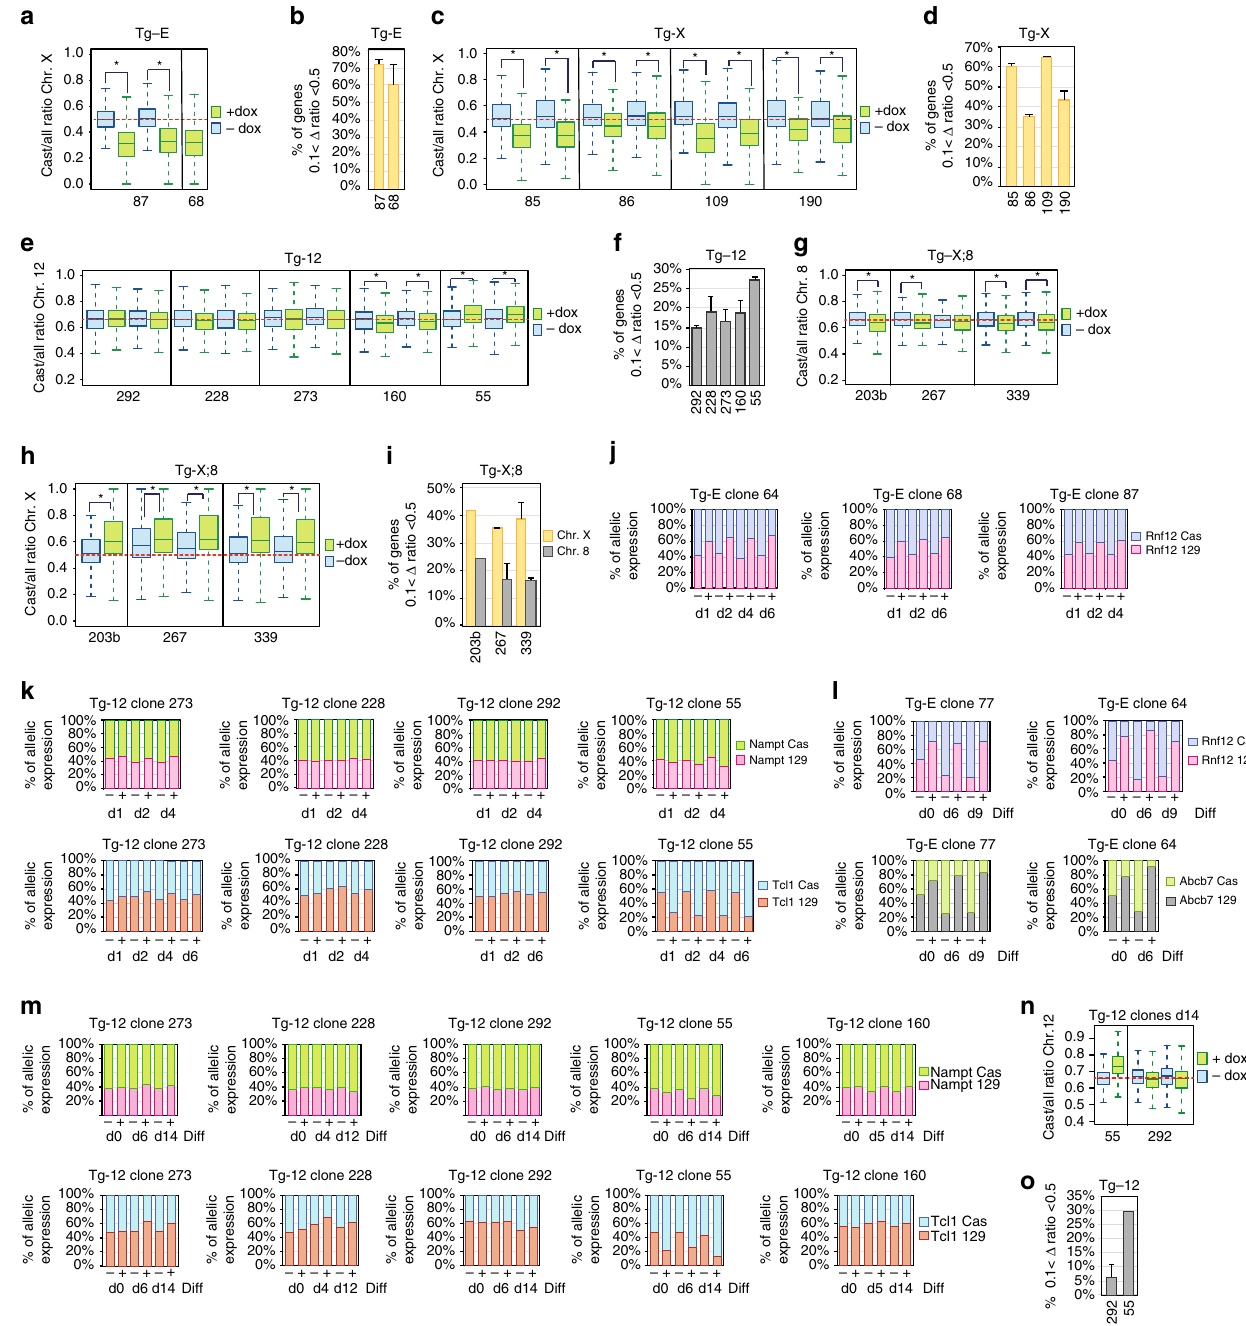
Fig. 3 Xist-mediated silencing at different genomic loci. a , c , h Box plot showing the Cast/all ratio of X-linked genes for Tg-E a , Tg-X c , and Tg-X;8 h clones after 5 days of doxycycline treatment in undifferentiated ESCs. e , g Box plot showing the Cast/all ratio of chromosome 12 and 8 genes in Tg-12 and Tg-X;8 clones after 5 days of doxycycline treatment in undifferentiated ESCs. * p < 0.05 Mann – Whitney U -test. b , d , f , i Bar graphs showing the percentage of genes with a Δ ratio between 0.1 and 0.5 after 5 days of doxycycline treatment in undifferentiated ESCs. Δ ratio = (Cast/all ratio ( − dox)) — (Cast/all ratio (+dox)). For each clone, data from two independent replicates are shown. j , k RT-PCR analysis followed by pyrosequencing at different time points after doxycycline induction in undifferentiated ESC clones grown in serum+ Lif conditions. Data for Rnf12 (Chr. X), Nampt , and Tcl1 are shown. l , m RT-PCR analysis followed by pyrosequencing at different time points of neuronal differentiation of Tg-12 and Tg-E clones. Data for Rnf12 and Abcb7 (Chr. X) and Nampt and Tcl1 (Chr.12) are shown. n Box plot showing Cast/all ratio of chromosome 12 genes for Tg-12 clones 55 and 292 upon doxycycline induction at day 14 of neuronal differentiation. o Bar graph showing the percentage of genes with a Δ ratio between 0.1 and 0.5 in clones 55 and 292 upon doxycycline induction at day 14 of neuronal differentiation. Δ ratio = ( − Cast/all ratio ( − dox)) — (Cast/all ratio